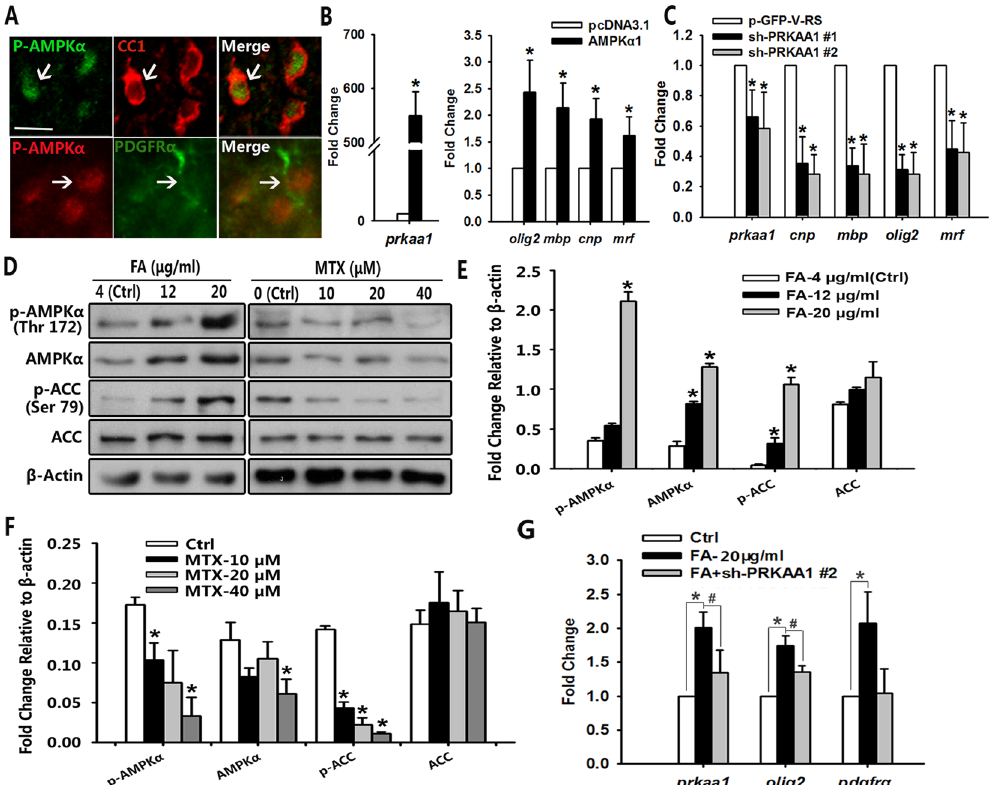
Figure 7. AMPK activity is involved in DHFR regulation of oligodendrocyte development. ( A ) The spinal cord of wild type mice at P8 was co-labeled for p-AMPK α with PDGFR α and CC1. Arrows indicate co-labeled cells. ( B ) qRT-PCR analysis of Prkaa1 , Olig2 , Mbp , Cnp and Myrf genes expression in Oli-neu cells transfected with AMPK α 1 and control plasmids for 48 h. Data represents the mean ± S.D. (n > 3, * p < 0 . 05 compared with the control, student’s t test). ( C ) qRT-PCR analysis of Prkaa1 , Olig2 , Mbp , Cnp and Myrf genes expression in Oli- neu cells transfected with AMPK α 1 sh-RNA (PRKAA1 #1 and #2) and control shRNA for 48 h. Data represents the mean ± S.D. (n > 3, * p < 0 . 05 compared with the control, one-way ANOVA). ( D ) Western blot analysis of p-AMPK α (60 kDa), AMPK α (60 kDa), p-ACC (280 kDa) and ACC (280 kDa) proteins expression in Oli-neu cells with folate or MTX treatment for 48 h compared to the individual control. β -actin (43 kDa) is the loading control. ( E , F ) Expression level of p-AMPK α , AMPK α , p-ACC and ACC proteins expression relative to β -actin of ( D ). Data represents the mean ± S.D. (n > 3, * p < 0 . 05 compared with the control, one-way ANOVA). ( G ) qRT-PCR analysis of Prkaa1 , Olig2 and Pdgfr α genes expression in Oli-neu cells treated with folate (20 μ g/ml) in the absence or presence of AMPK α shRNA#2 for 48 h. Data represents the mean ± S.D. (n > 3, * p < 0 . 05 , one-way ANOVA). Scale bars: 40 μ m ( A